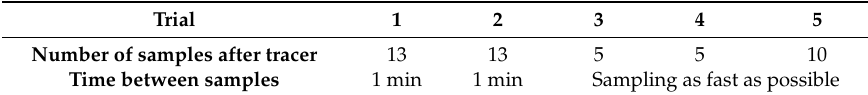
Table 1. Overall sampling procedure for the five mixing-time trials.